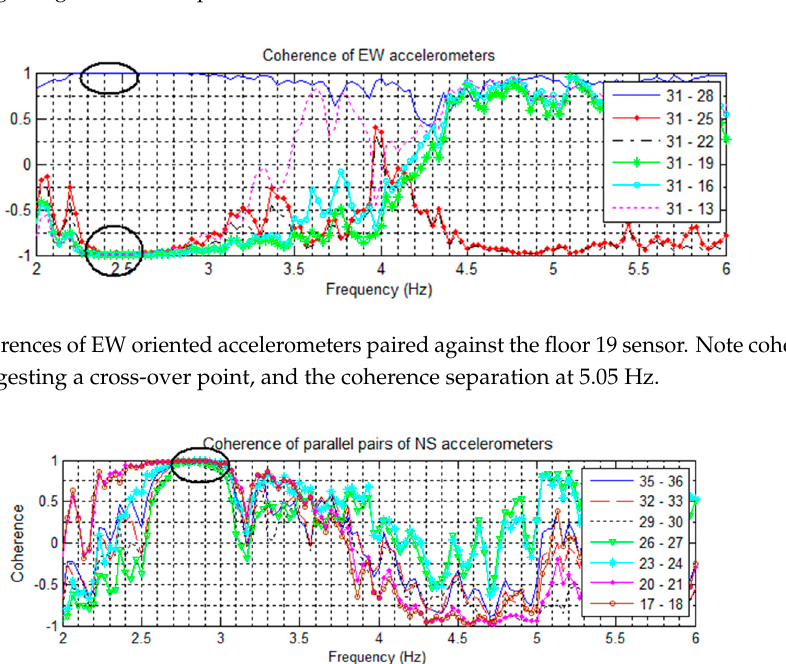
Figure 10. Coherences of parallel pairs of NS oriented accelerometers from the 14 May event. The strong positive coherence at 2.81 Hz suggests a NS mode.